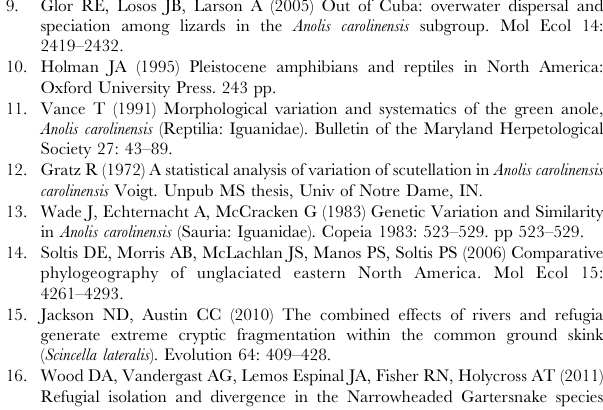
Figure S1 Unrooted ML trees for intronic sequences. We performed phylogenetic inference using Maximum Likelihood (ML) in MEGA 5.0 with 1000 bootstrap replicates (bootstrap values not shown). Trees are unrooted due to lack of an outgroup. Circles are roughly proportional to the number of individuals present at a node, and pie charts reflect proportion of individuals at each node belonging to one of four major mitochondrial clades: Gulf-Atlantic (green), North Carolina (red), Suwannee (blue), Everlgades (magenta). Table S1 Collecting localities and GPS coordinates. Table S2 Predicted protein products for the intronic sequences used in this study. Table S3 Primers for PCR products used in this study.